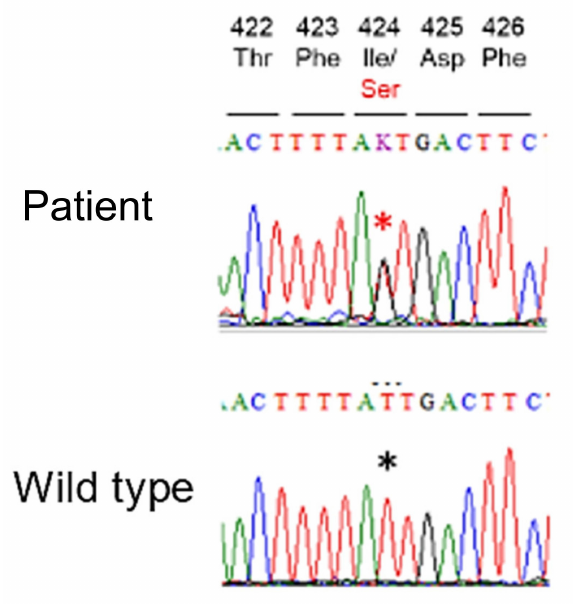
Figure 3. Genetic analysis reveals a novel missense mutation in the PKD2 gene of the patient. DNA sequence codes: A (adenine), C (cytosine), G (guanine), T (thymine) and K (T or G). Red asterisk indicates T to G mutation. Black asterisk is wild-type gene sequence, on the same position as red asterisk. The DNA sequence of the patient has one allele wild type T and the other has a mutation G. The upper numbers 422 to 426 indicate aa (amino acid) residue of